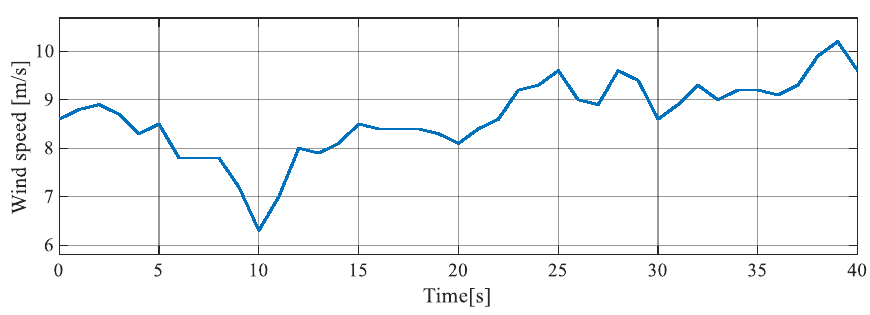
Figure 16. Real wind speed profile used in the simulation.